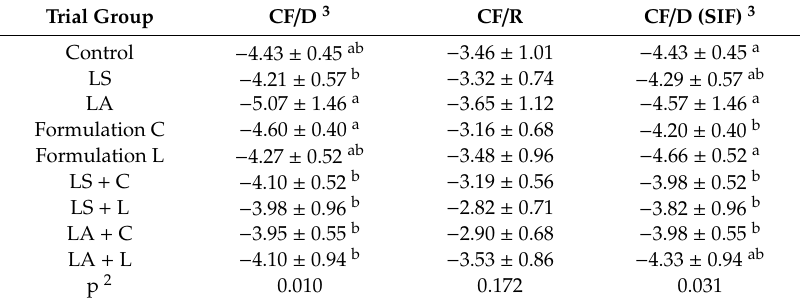
Table 4. Impact of DFM and phytobiotic feed additives on CF after 4 h incubation of donor ( E.